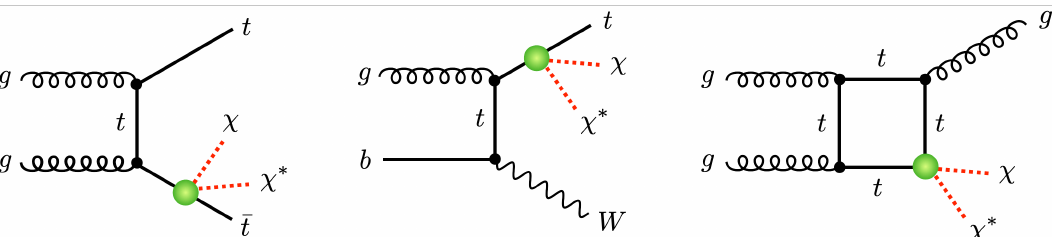
Figure 2 . Assortment of graphs with insertions of the DM-top operators (filled green circles) entering (2.1) that give rise to a t ¯ t + E miss